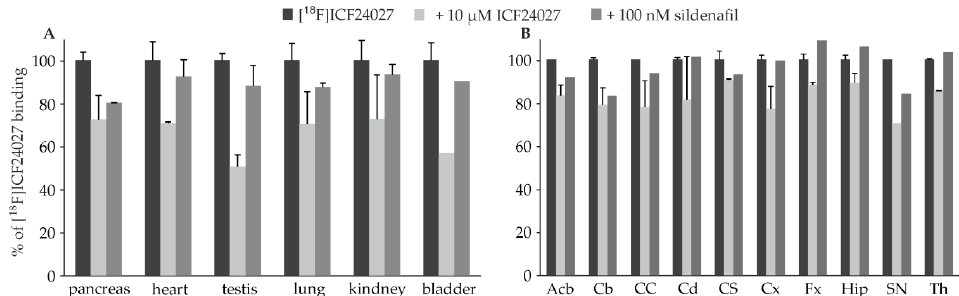
Figure 3. Selectivity of the binding of [ 18 F] ICF24027 in ( A ) different mouse tissue and ( B ) porcine brain in vitro ( n = 2). Remaining binding of 5.26 nM [ 18 F] ICF24027 in the presence of 10 μ M ICF24027 or 100 nM sildenafil is presented as percentage of total binding (=100%). Abbreviations: Acb = Nucleus accumbens, Cb = Cerebellum, CC = Corpus callosum, Cd = Nucleus caudatus, Cx = Cortex, CS = Colliculus superior, Fx = Fornix, Hip = Hippocampus, SN = Substantia nigra, Th = Thalamus.